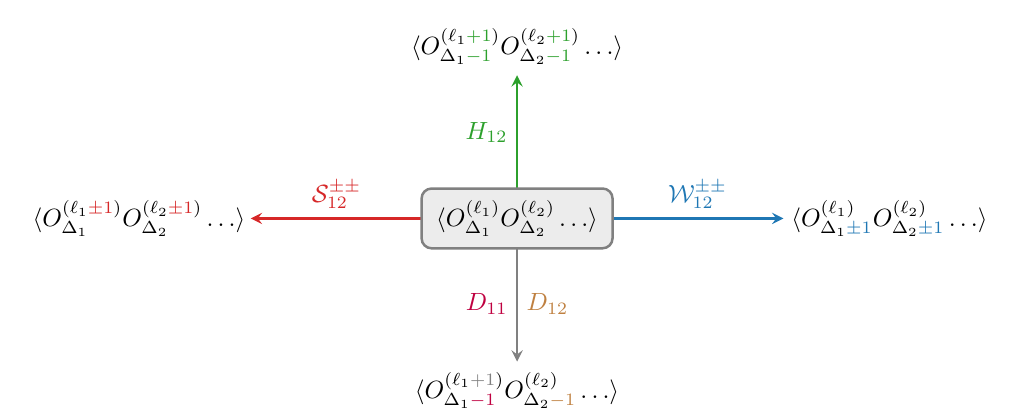
Figure 3: Schematic illustration of the different weight-shifting operators used in this